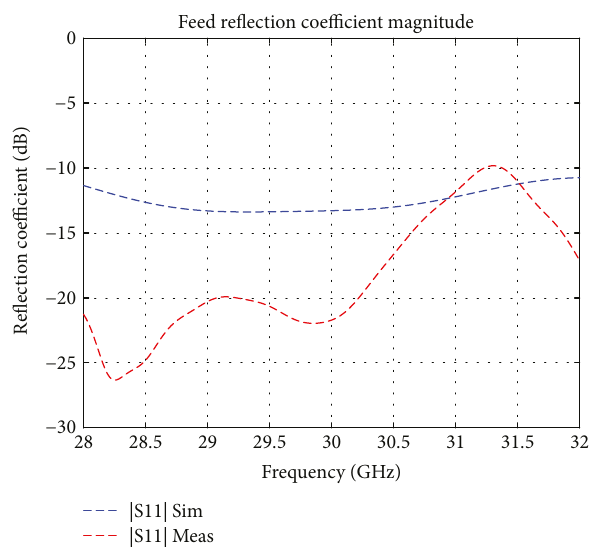
Figure 9: Simulated and measured re fl ection coe ffi cient magnitude versus frequency from the proposed re fl ector.